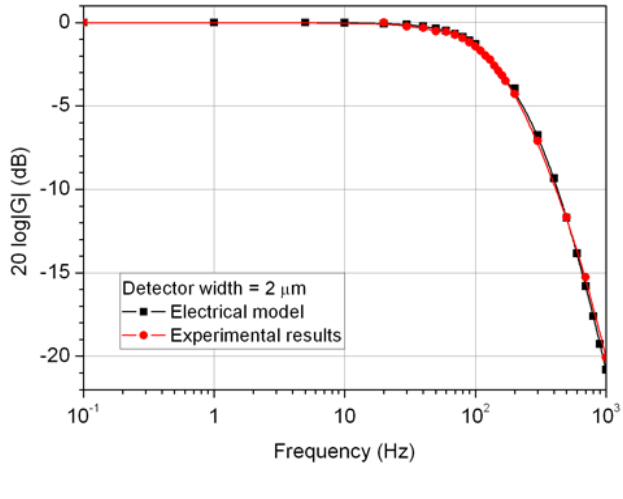
Figure 8. Theoretical electrical model and the experimental response of the thermal accelerometer for a detector width of 2